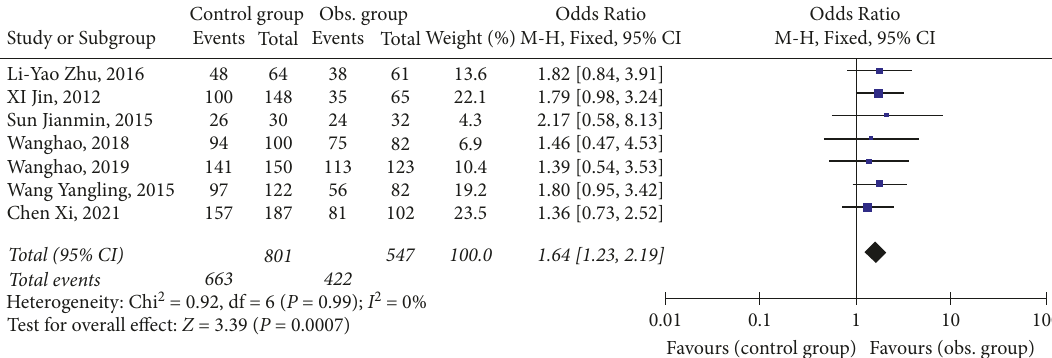
Figure 2: Data of HBV DNA negative conversion after 48-week antivirus.